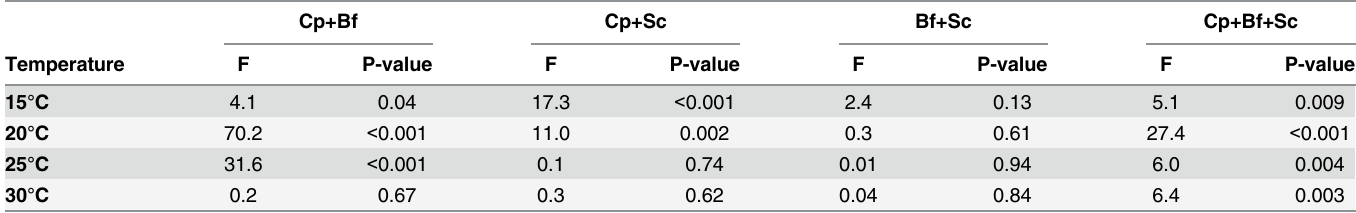
Table 4. Results of ANOVA comparing relative growth rates between borer species in multi-species communities at different constant